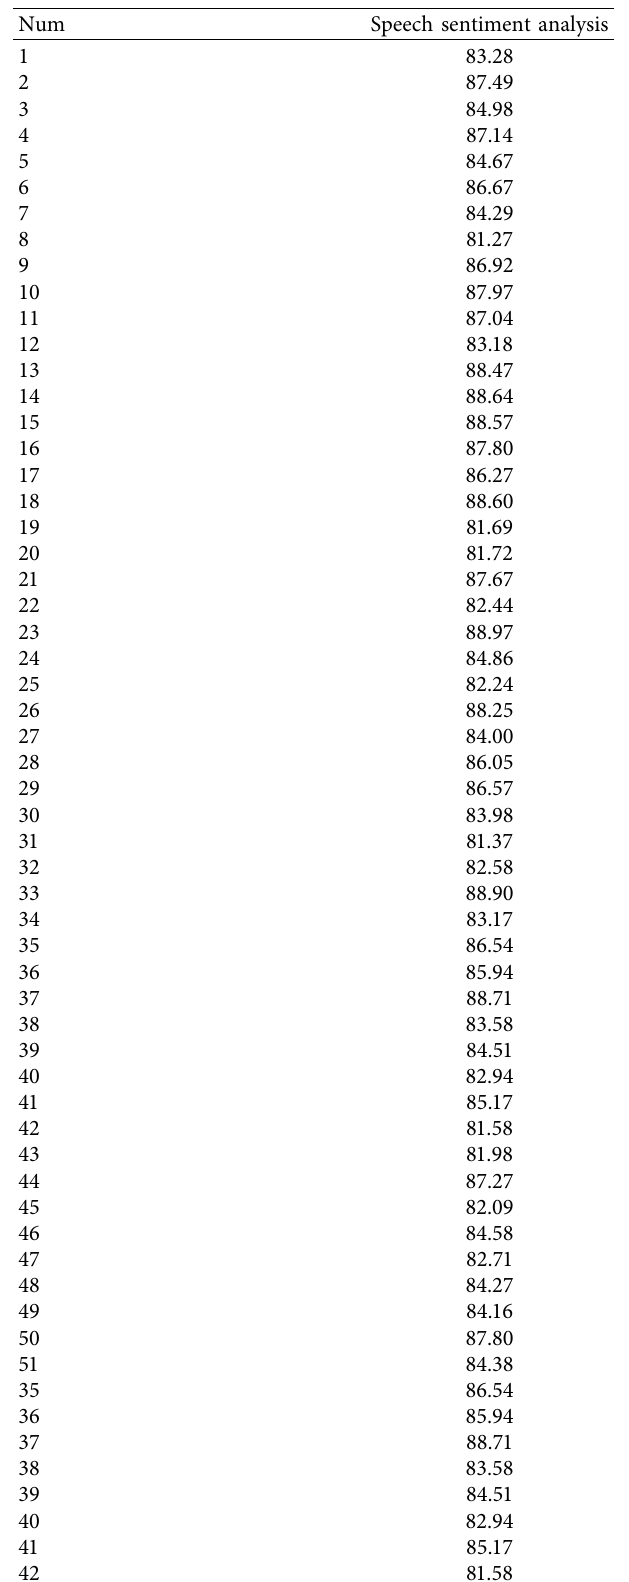
Table 1: The effect of multilingual speech sentiment analysis model based on data